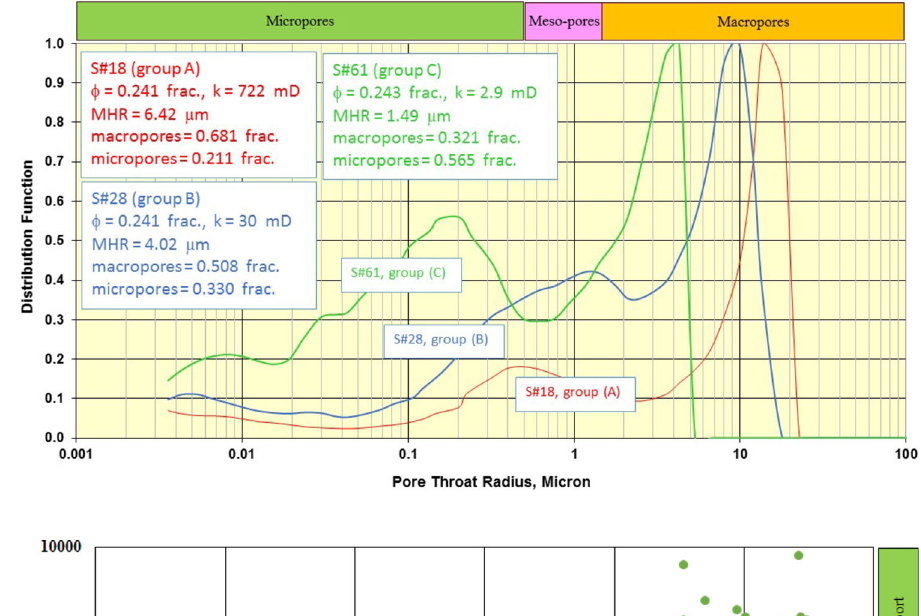
permeability using Winland’s flow